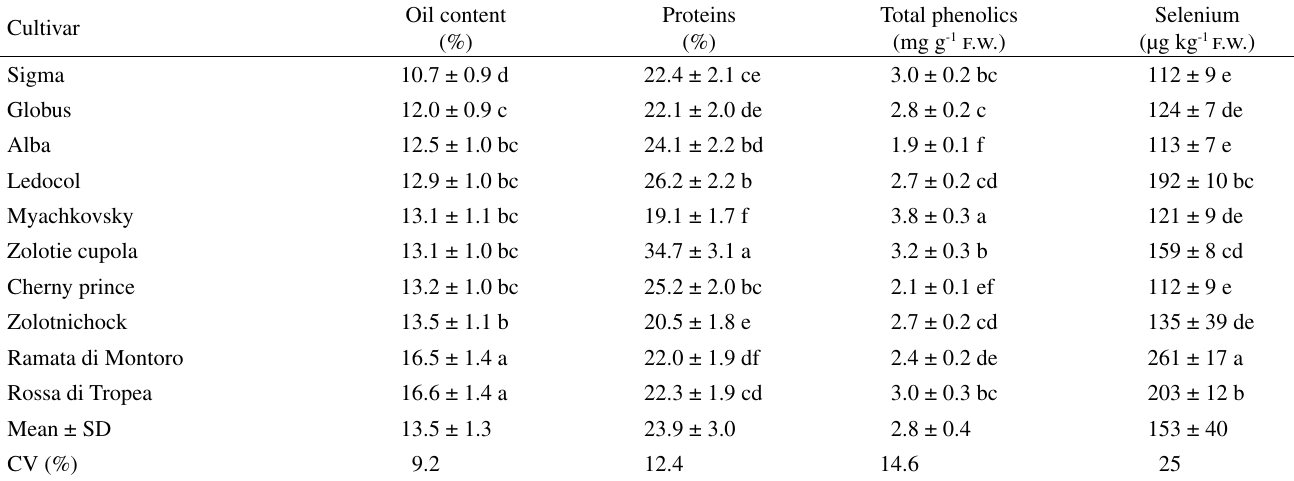
Within each column: the data are reported as mean ± standard deviation; CV = coefficient of variation; means followed by different letters are sig- nificantly different according to the Duncan test at p≤0.05 (n=3).